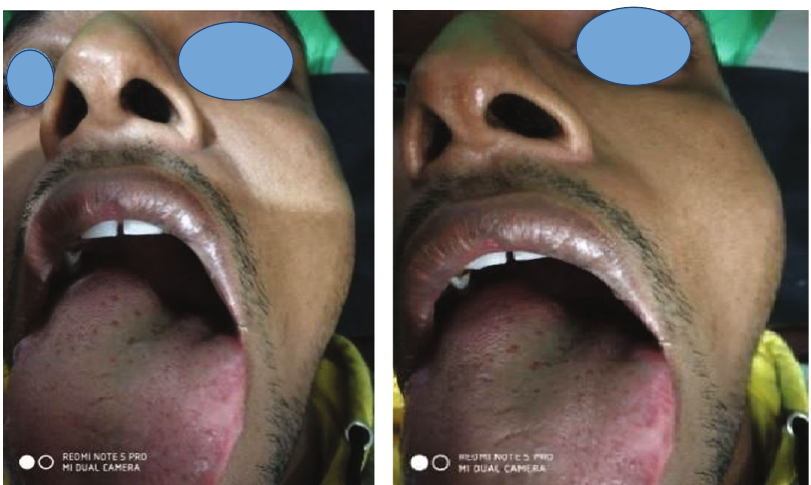
Figure 1: Large asymptomatic swelling at posterolateral aspect of right side of tongue.